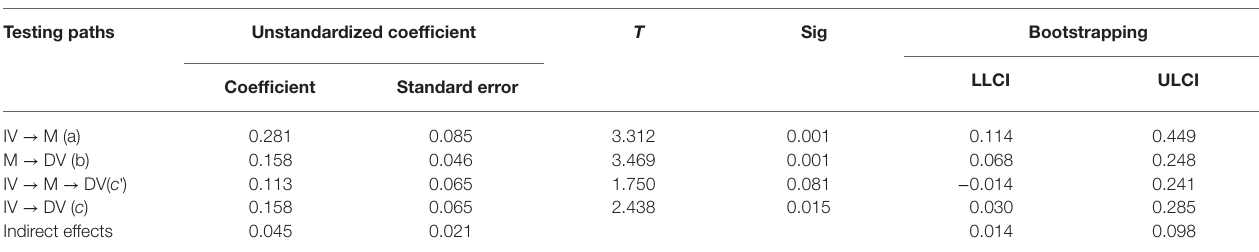
TABLE 4 | Coefficient and bootstrapping for the mediation. Testing